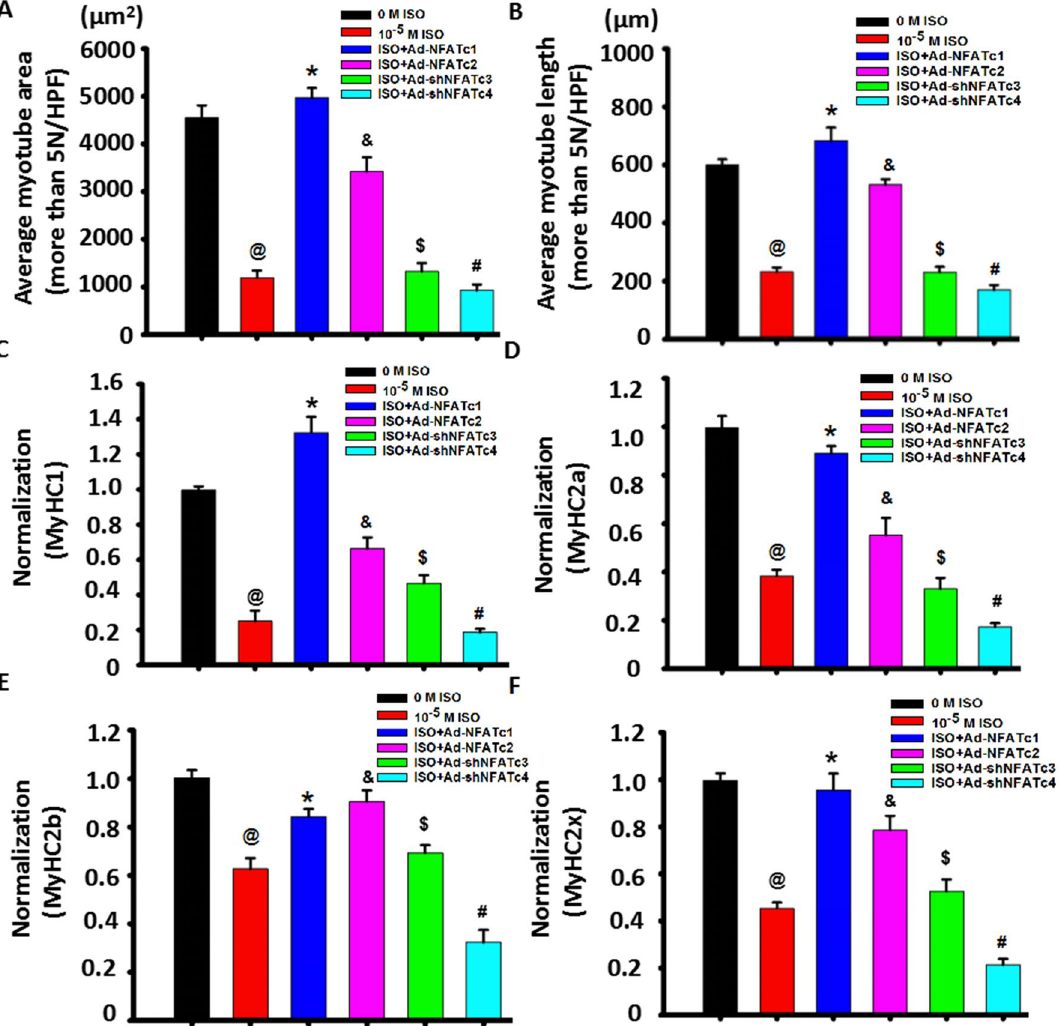
Figure 7. NFAT signaling is involved in the regulation of myotube types mediated by ISO. (A) Myoblast cells were stimulated with continuous single-dose ISO under DM for five days and stained with MyHC 24 h after the cells were transfected with Ad-NFATc1, Ad-NFATc2, Ad-shNFATc3 or Ad-shNFATc4 at 100 MOI. The average myotube area of MyHC + myotubes with 5 + nuclei is shown in Fig. 6, as detected by MyHC staining. n = 3, @ P < 0.05 versus Ctrl; *P < 0.05 versus ISO group; & P < 0.05 versus ISO group or ISO + Ad-NFATc1 group; # P > 0.05 versus ISO group; $ P > 0.05 versus ISO group. N: nuclei. ( B ) Quantitative assay for average myotube length of MyHC + myotubes with 5 + nuclei from Fig. 6. n = 3, @ P < 0.05 versus Ctrl; *P < 0.05 versus ISO group; & P < 0.05 versus ISO group or ISO + Ad-NFATc1 group; # P > 0.05 versus ISO group; $ P > 0.05 versus ISO group. ( C – F ) Myoblast cells were transfected with the indicated adenovirus for 24 h prior to stimulation with continuous single-dose ISO for six days. Then, real-time PCR was used to evaluate MyHC1, MyHC2a, MyHC2b and MyHC2x mRNA expression in differentiated myoblast cells. n = 3, @ P < 0.05 versus Ctrl; *P < 0.05 versus ISO group; & P < 0.05 versus ISO group or ISO + Ad-NFATc1 group; $ P > 0.05 versus ISO group; # P > 0.05 versus ISO group. Three independently repeated experiments were